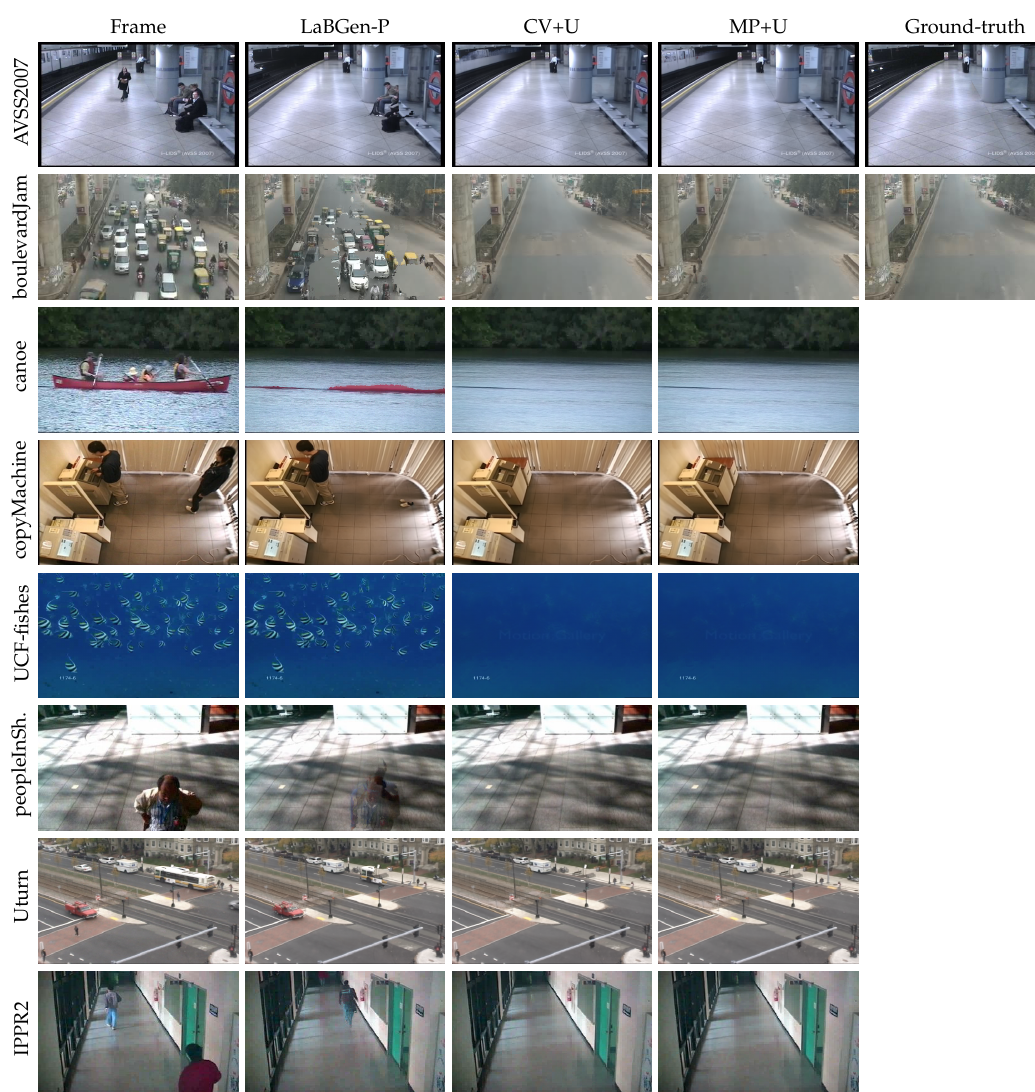
Figure 7. Visual results showing some major improvements brought by LaBGen-P-Semantic with CV+U and MP+U on some SBMnet video sequences. A random frame of the input video sequence along with the ground-truth (when available) are also